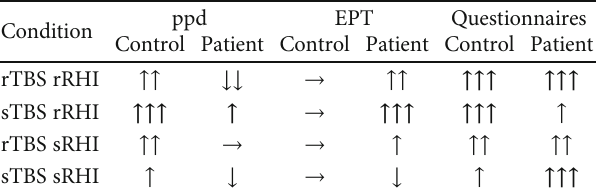
→ → ↑ ↑↑ ↑↑ ↑ ↓ → ↓ ↑ ↑↑↑ rRHI: real rubber hand illusion; sRHI: sham rubber hand illusion; rTBS: real theta burst stimulation; sTBS: sham theta burst stimulation; ppd: proprioceptive drift; EPT: electrical perception test. Arrows mean either → no e ff ect, ↓ negative e ff ect, or ↑ positive e ff ect. Numbers of arrows represent the intensity of the e ff